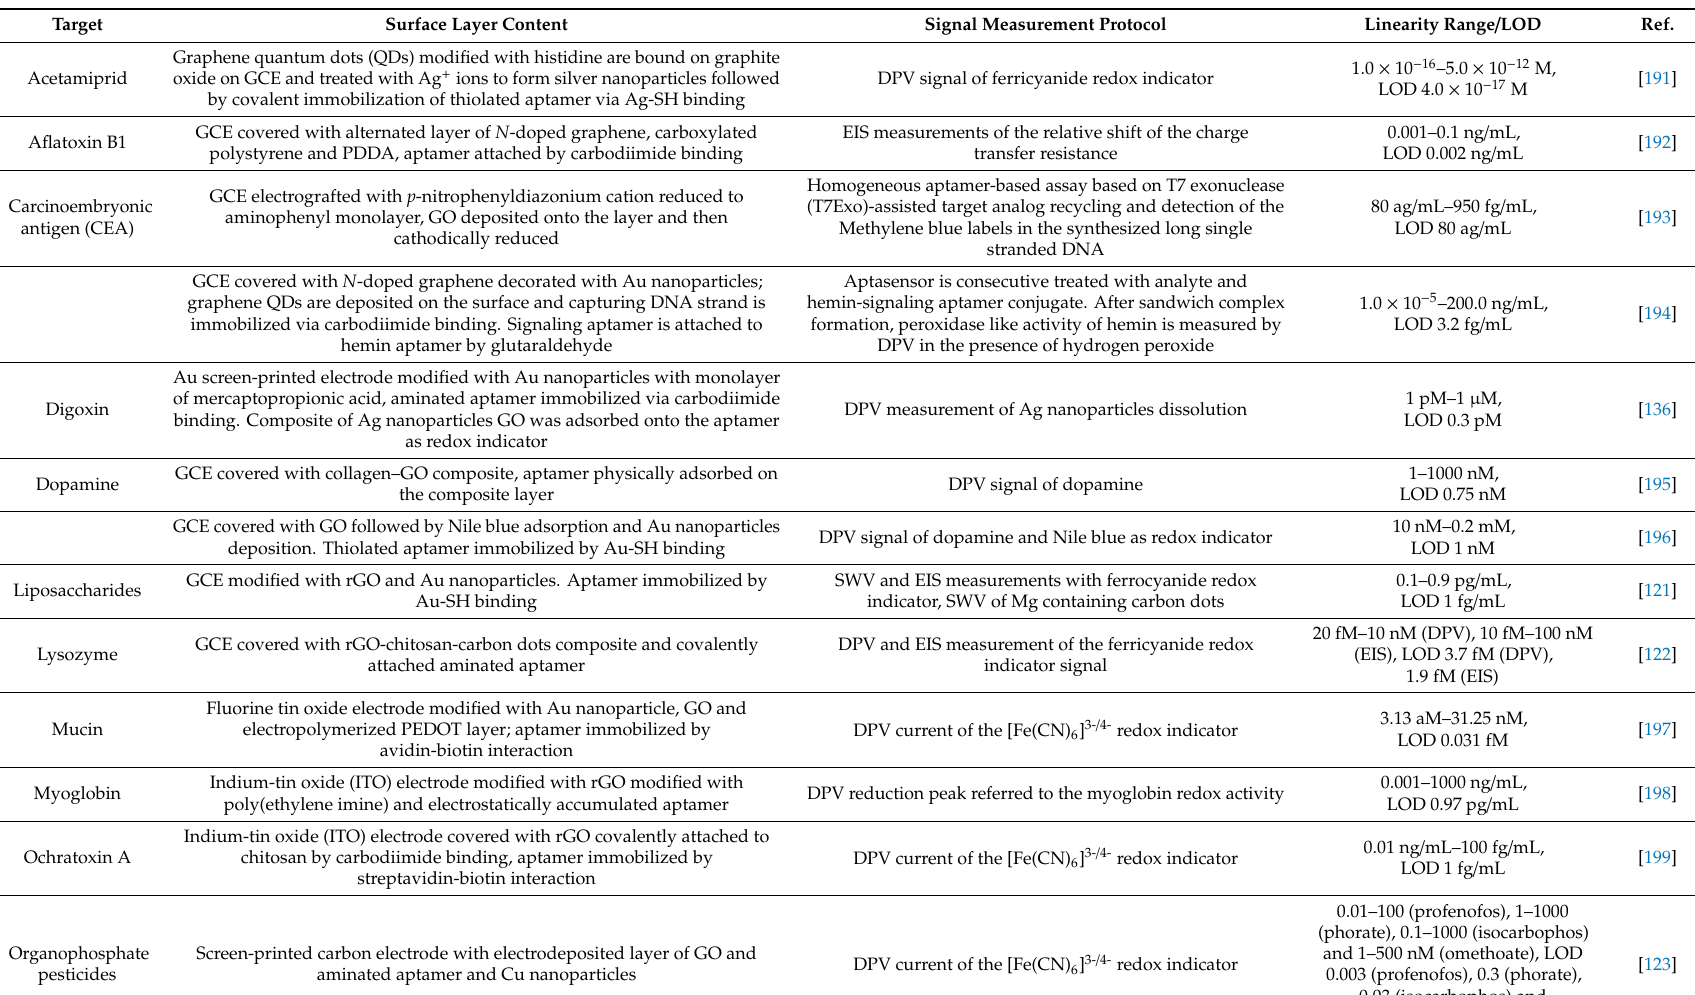
Table 2. Characteristics of electrochemical aptasensors based on graphene and related materials